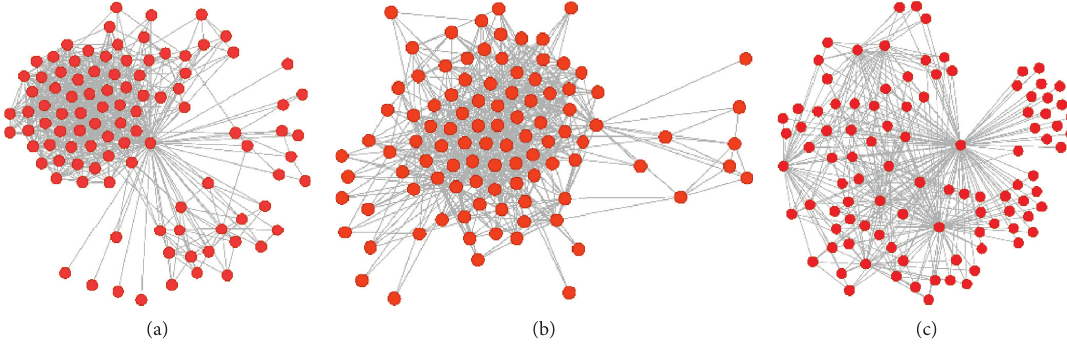
Figure 2: Three real-world OSNs: (a) G